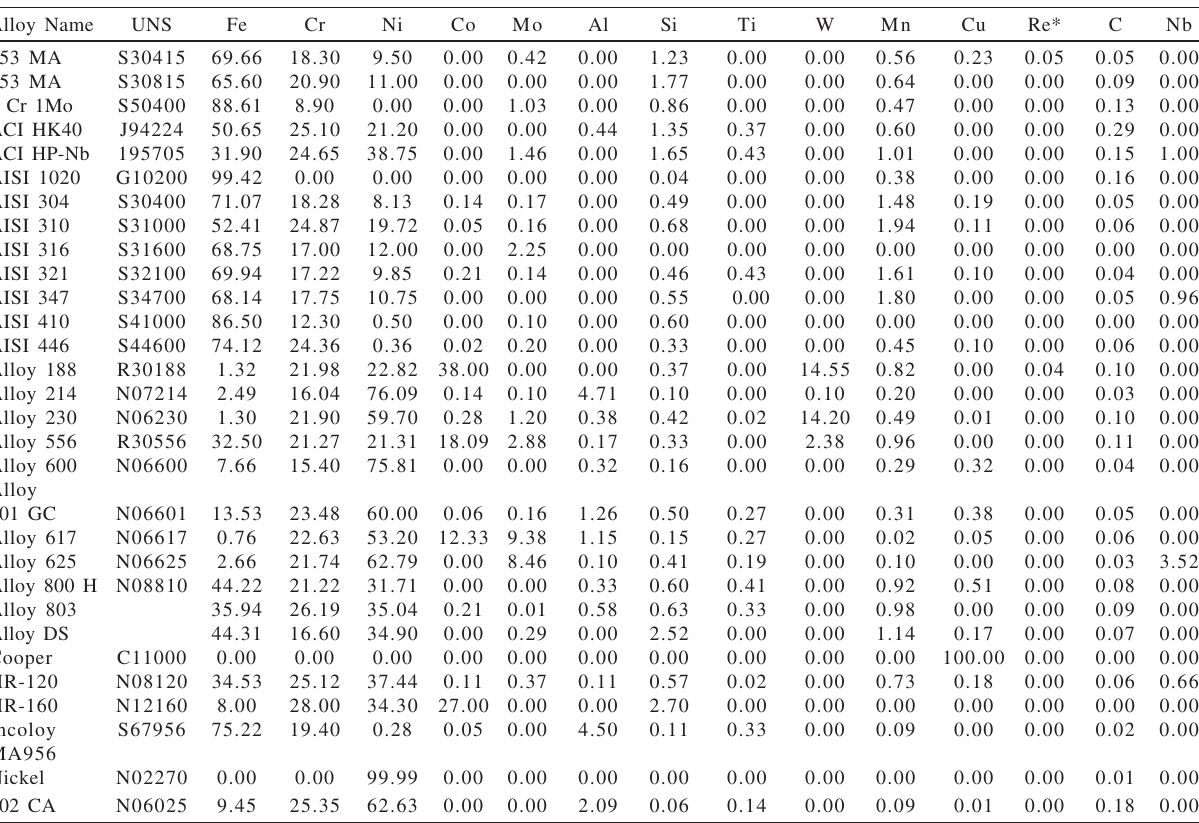
Table 1. Compositions in wt% of Some Alloys in The